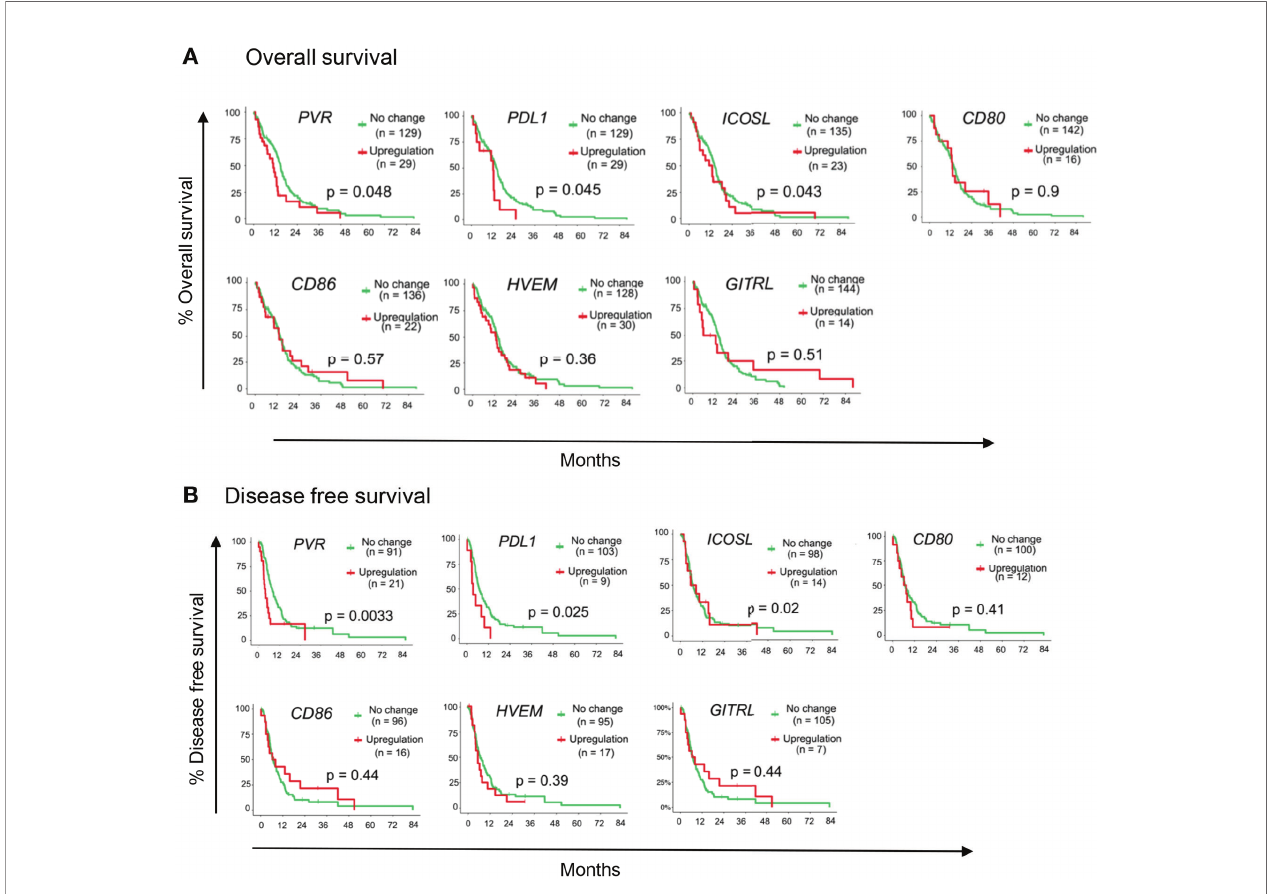
FIGURE 2 | Immune-checkpoint ligand genes associated with GBM patient outcome. TCGA patient survival data obtained from cBioPortal, and patients were grouped based on gene expression z-scores to upregulated expression (z ≥ 2; red line) or no change expression (z <2; green line). The (A) overall survival rate, and (B) disease free survival rates were plotted using Kaplan-Meier survival curves. P values re fl ect one-way ANOVA with Kruskal Wallis comparison test.